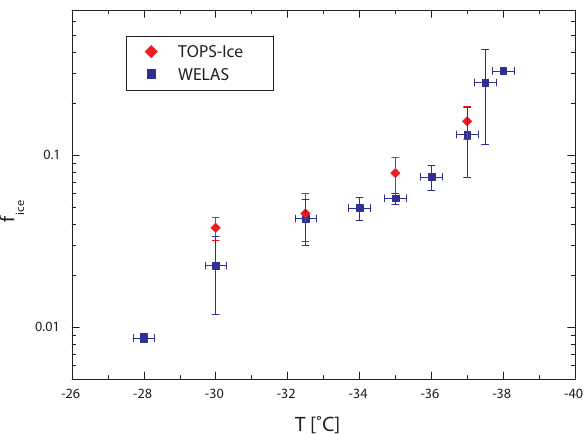
Fig. 10. Comparison of the ice fraction vs. freezing temperature determined with WELAS (Niedermeier et al., 2010, 2011) and with TOPS-Ice. 300nm Arizona Test Dust particles were used for both